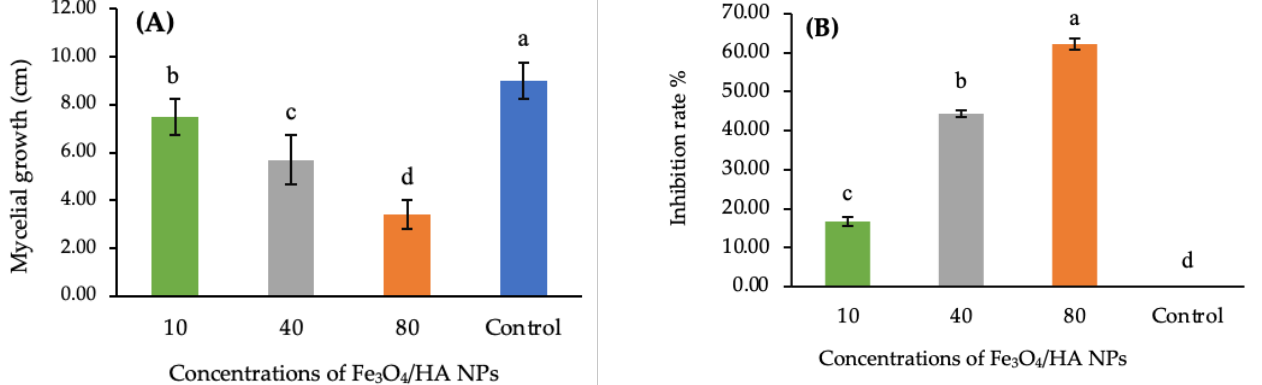
Figure 2. Inhibitory effect of Fe 3 O 4 /HA NPs on the mycelial growth of A . striticum ( A ) and inhibition rate ( B ). Same letter in the figure means no significant differences between the values.